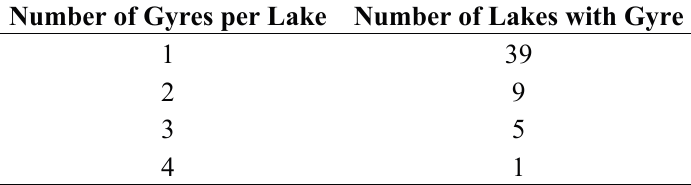
Table 4. Occurrence of gyres in the Barrow study area on 10 July 2013.